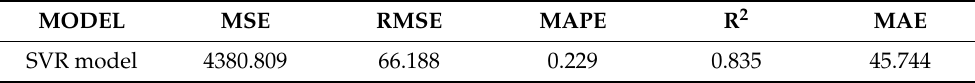
Table 4. Validation Metrics of the SVR model.